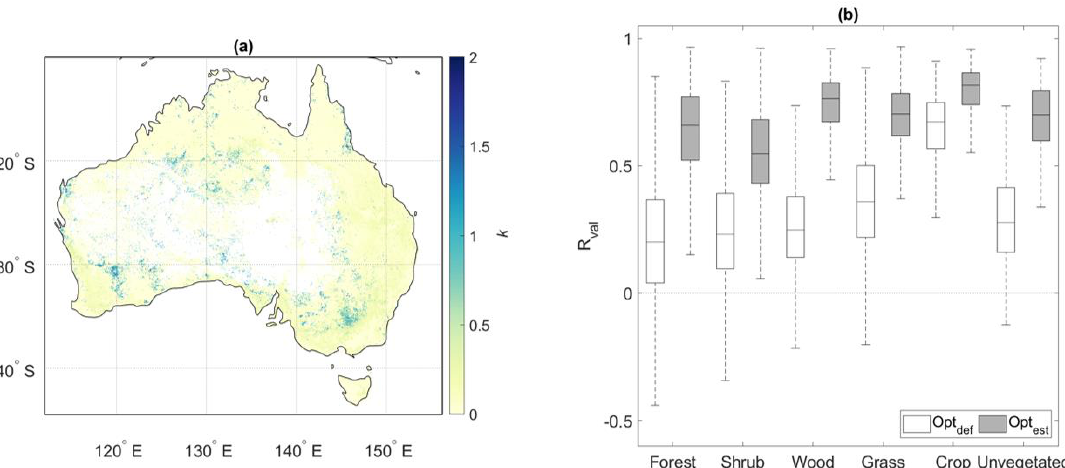
Figure 2. ( a ) Estimated k values over the seven-year calibration period (2002 to 2009). Note that the white-space regions in the map were excluded from the optimization due to lack of LAI data. ( b ) Box plots presenting correlation coefficients over the five-year validation period (2010 to 2014) (R val ) between the MODIS and estimated LAI by Opt and Opt approaches conditioned by the six def est primary land cover classes across Australia.